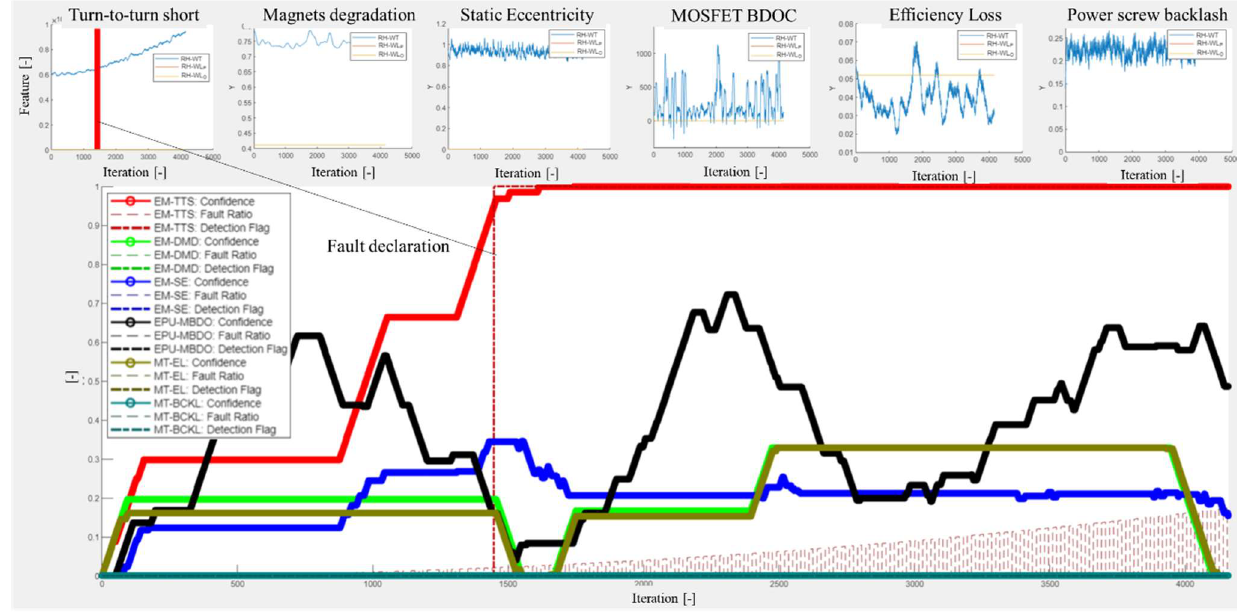
Figure 16. Output of the fault-detection algorithm in response to fault occurrence in the winglet